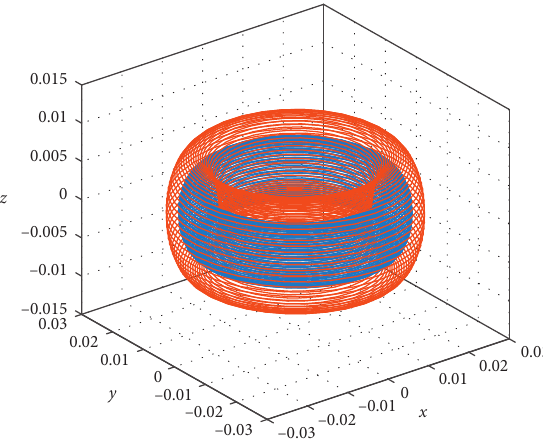
Figure 4: Two invariant tori with different initial values for a � 10 − 4